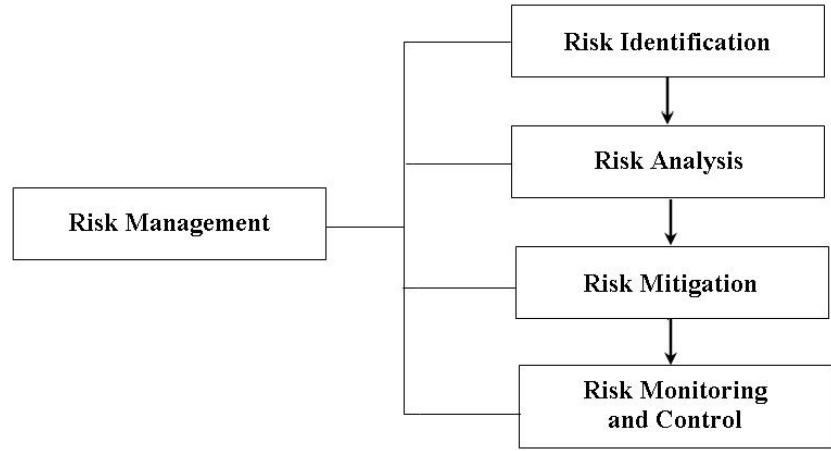
Figure 2. "Fundamental Concept of Risk